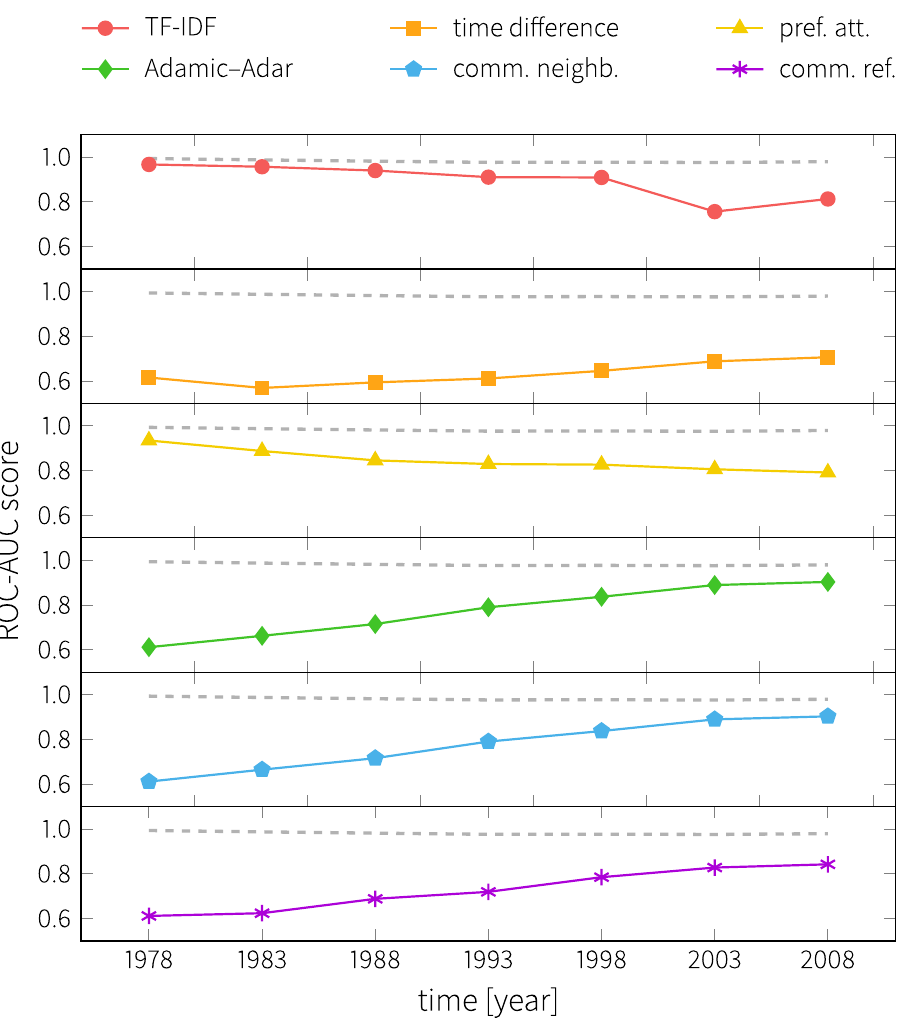
Figure 4. Predictive power of individual features. Lines show the change in ROC-AUC for each feature calculated from the raw feature values. The dashed gray lines show the value 1.0 as a guide to the